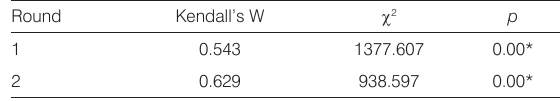
Table 1. Coefficients and significance testing results.